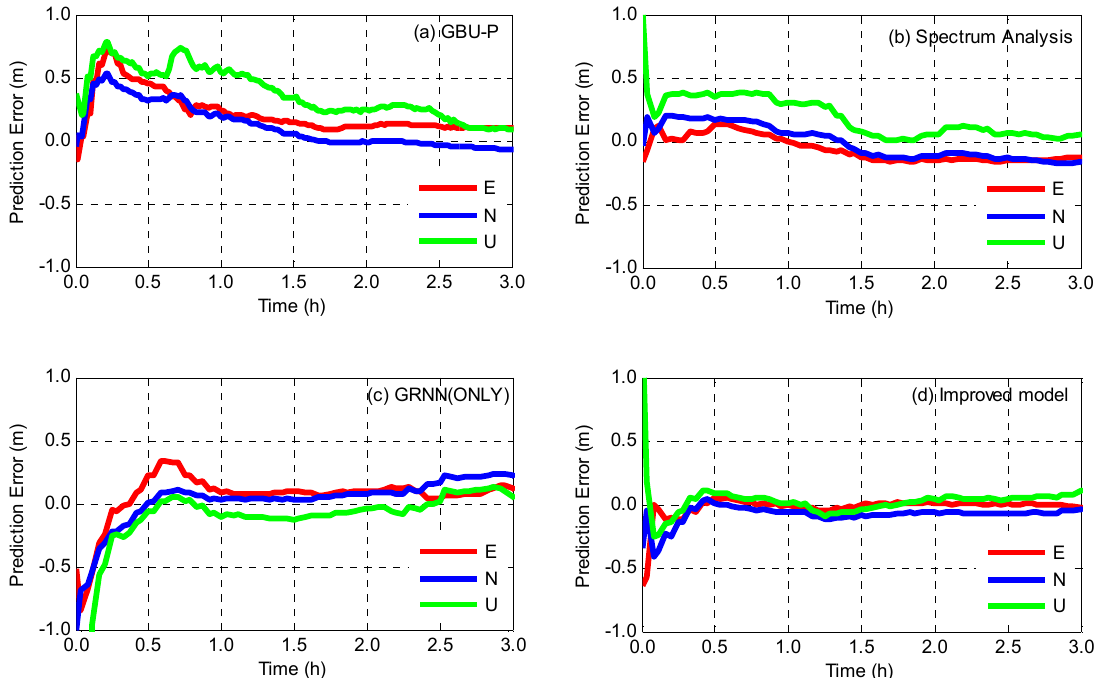
Figure 10. Position residuals of kinematic PPP for DARW station using ( a ) GBU-P, ( b ) spectrum analysis, ( c ) GRNN(ONLY) and ( d ) improved model, respectively.